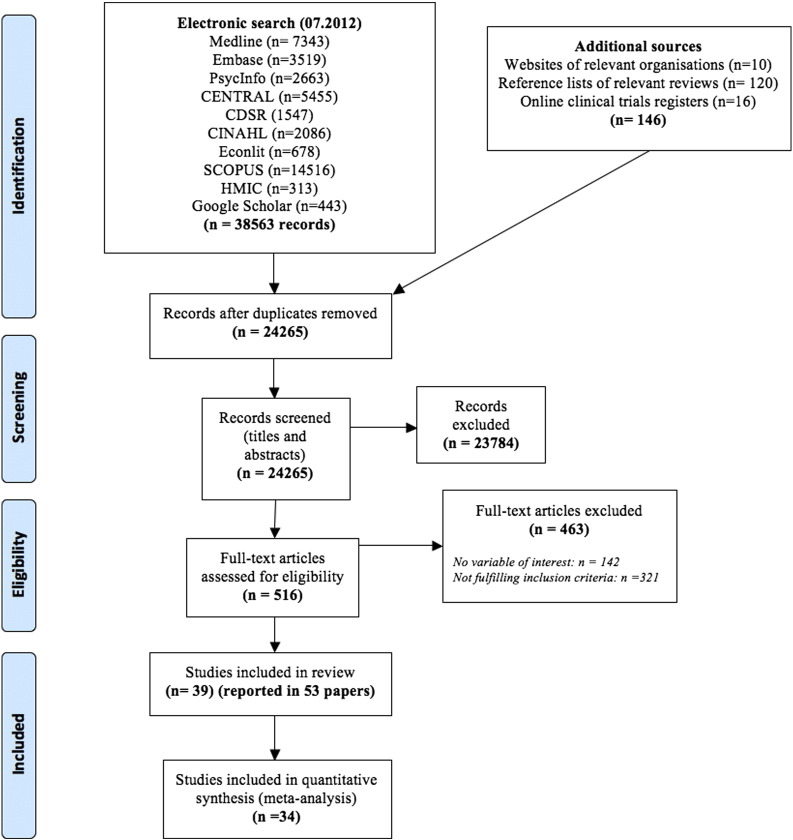
PRISMA flow diagram.